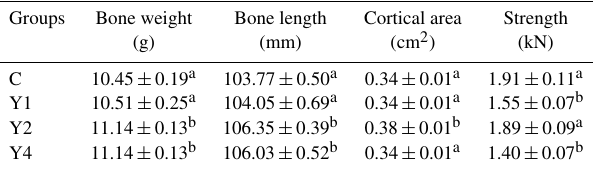
Table 2. Effects of Saccharomyces cerevisiae on broiler tibiotarsus weight, length, cortical area and strength.